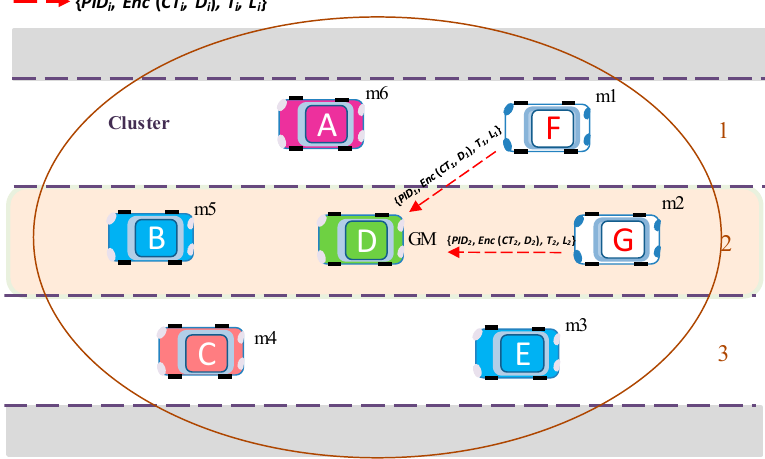
Figure 6. The key request messaging to GM. Sensors 2020 , 20 , x